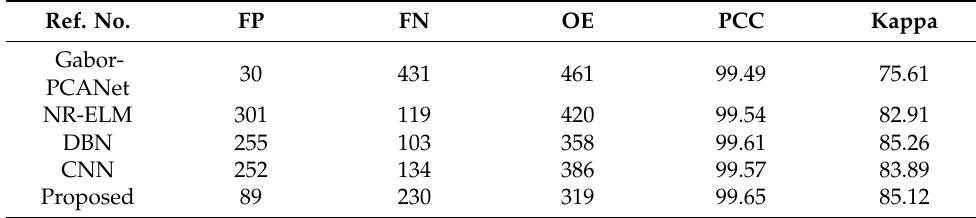
Figure 18. Change detection results on the Bern dataset. ( a ) Ground truth. ( b ) Result by Gabor- PCANet. ( c ) Result by NR-ELM. ( d ) Result by DBN. ( e ) Result by CNN. ( f ) Result by our pro- posed method. Table 5. Change detection results of the Bern